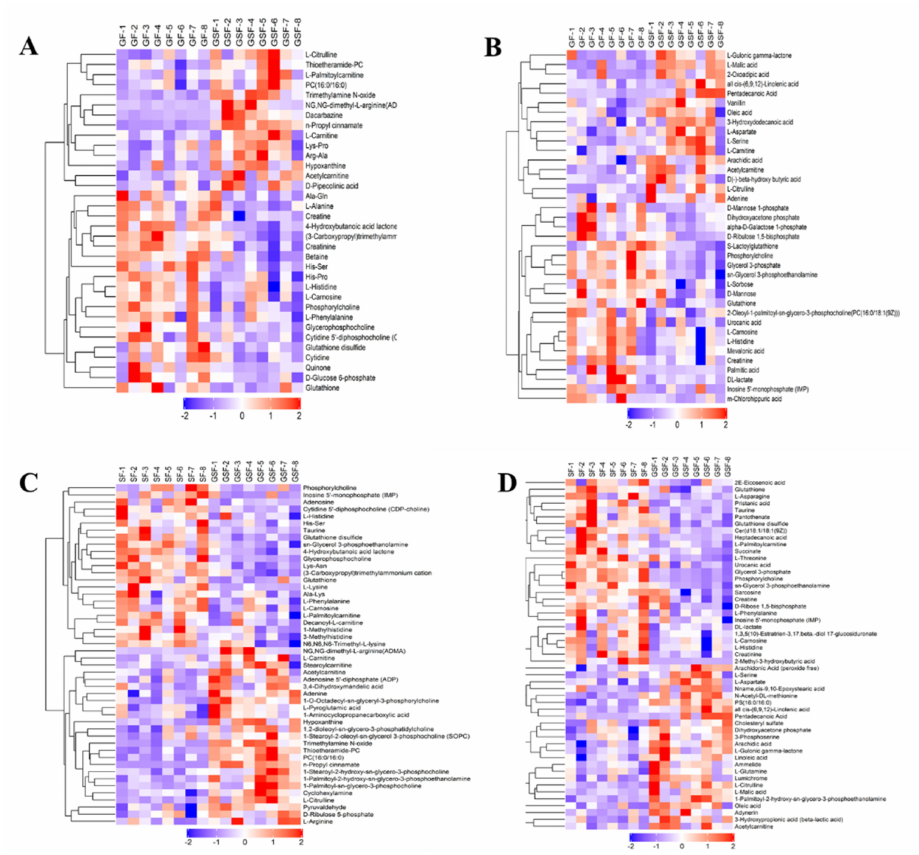
Figure 3. Hierarchical cluster results of differential metabolites under positive- and negative-ion modes in the GF vs GSF ( A , B ) and SF vs GSF ( C , D ) groups. GSF, graze-feeding group; GF, time- limited graze-feeding group; SF, stall-feeding group. n = 8 for each